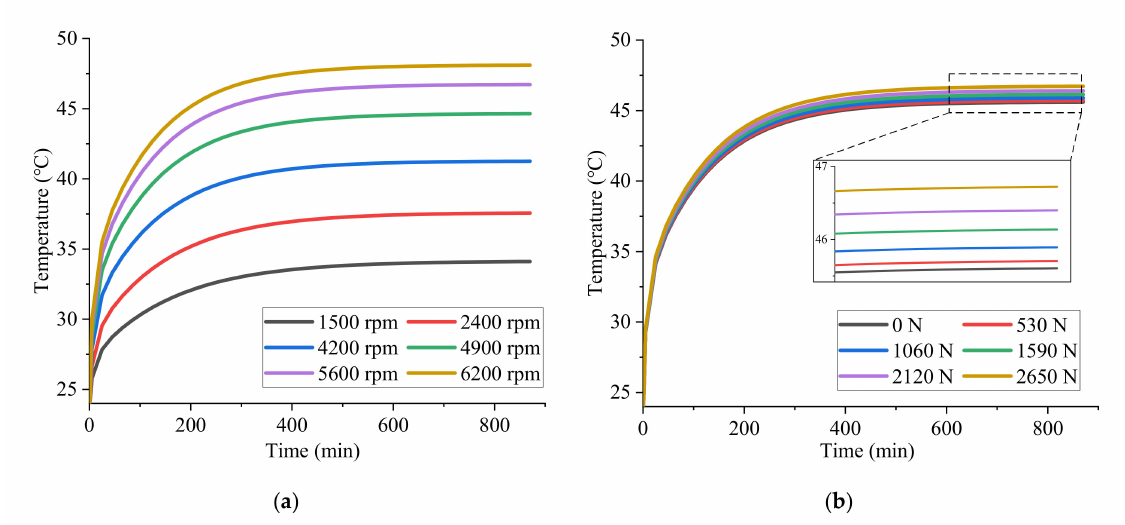
Figure 11. Average temperature curve of constant load / variable speed and constant speed / variable load. ( a ) Constant load / variable speed; ( b ) Constant speed / variable